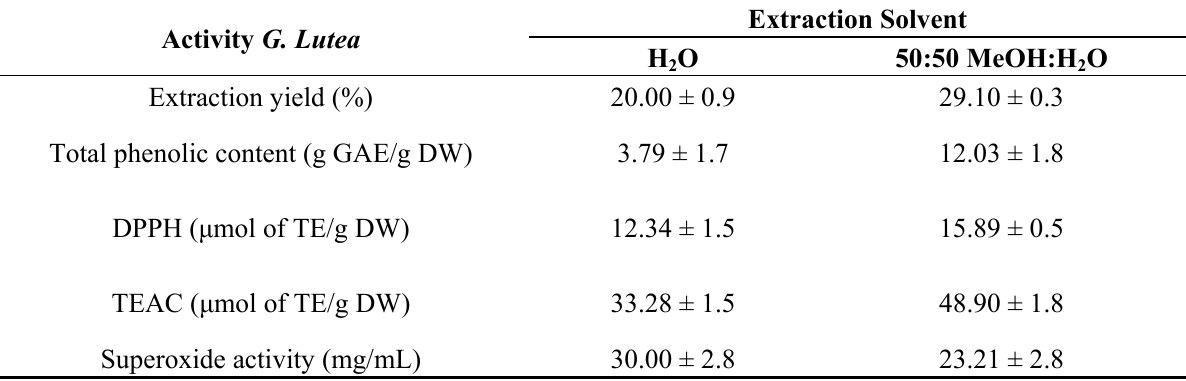
Table 1. Extraction yield, total phenolic content (TPC),